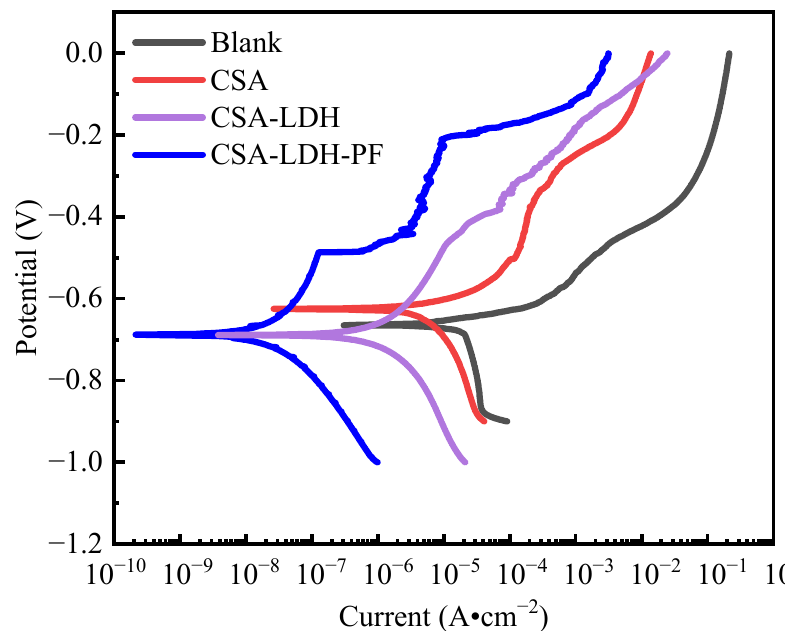
Figure 7. Polarization curves of samples with different anodizing and sealing treatments in 3.5 wt.% NaCl solutions. Table 5. Fitting results of the polarization curves in Figure 7.